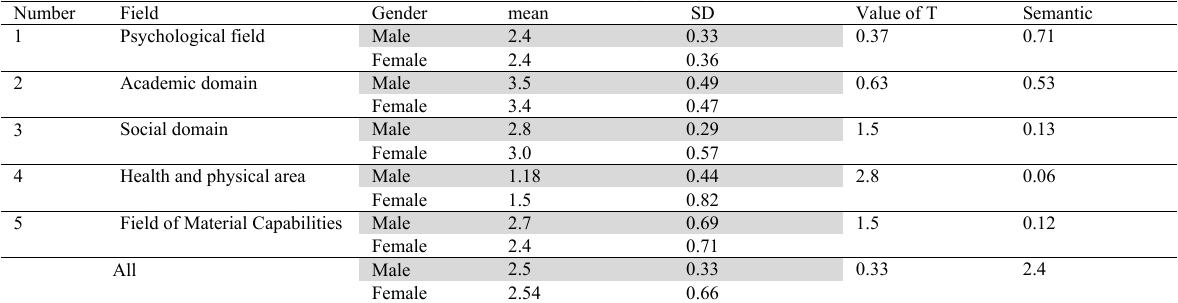
Arithmetic mean, standard deviation and T value of study areas by gender